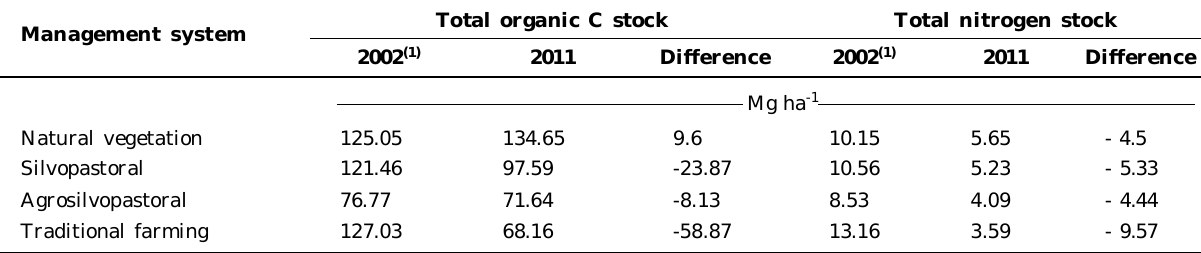
Table 5. Total organic C and total N stocks in 2002 and 2011 in a typical Ortic Chromic Luvisol under natural vegetation (NV) and silvopastoral (SILV), agrosilvopastoral (AGP) and traditional agricultural (TR) systems in the 0-40 cm layer in Sobral, Ceará